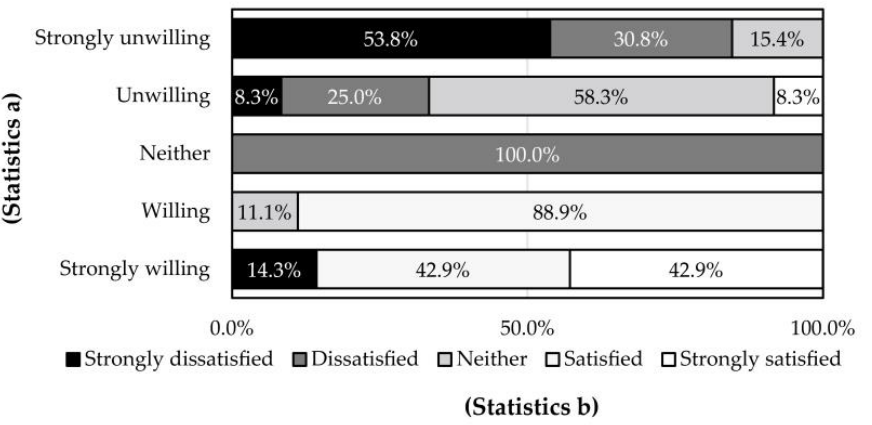
Figure 5. Cross analysis of the willingness for continuous use (Statistics a) with satisfaction of management time for rainwater harvesting (Statistics b) ( p = 0.000).